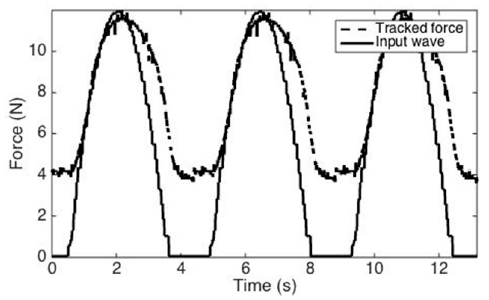
Figure 12. Closed-loop control with force sensor (input: 1 Hz sine wave).